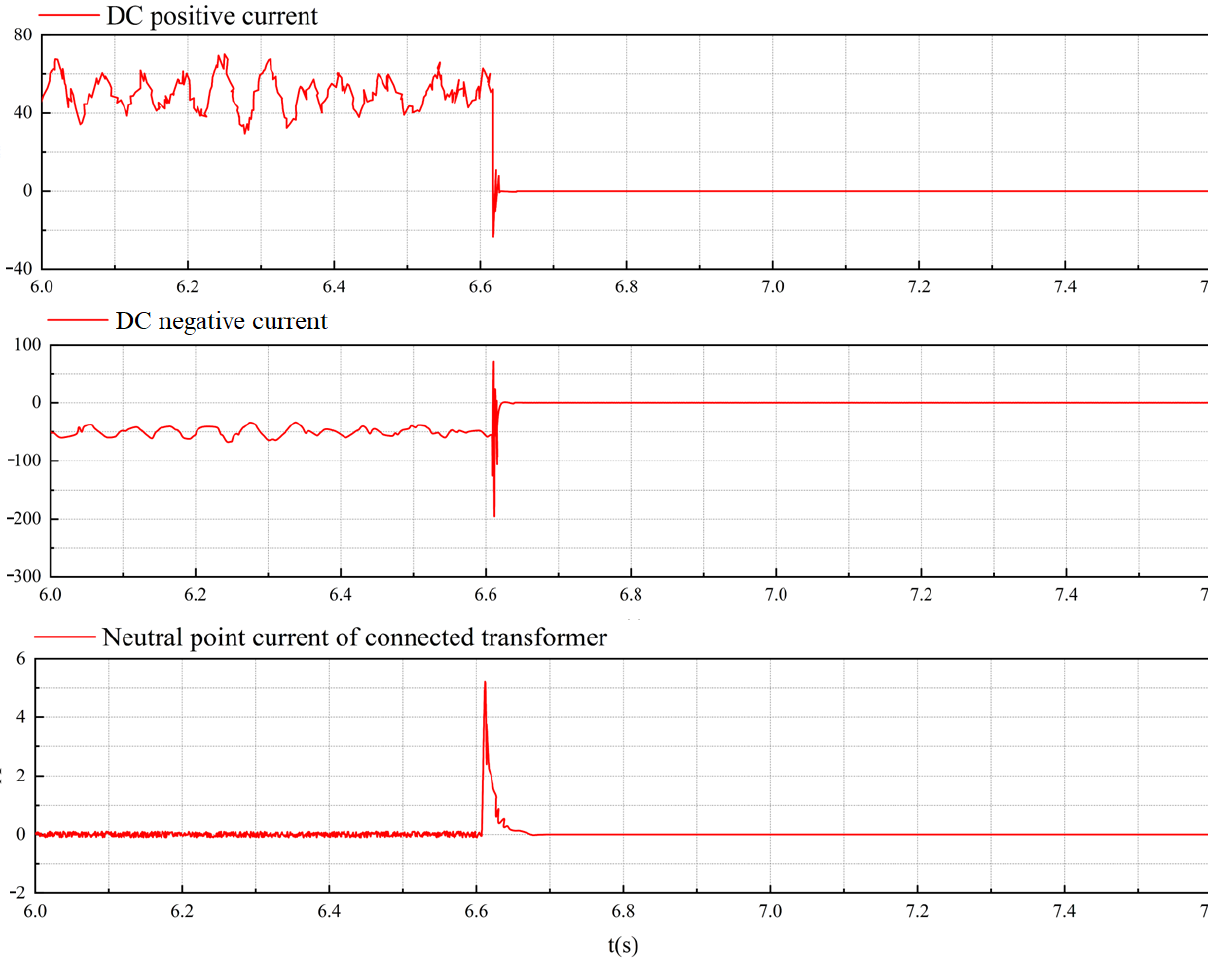
Figure 5. DC side current and neutral point current of T3.